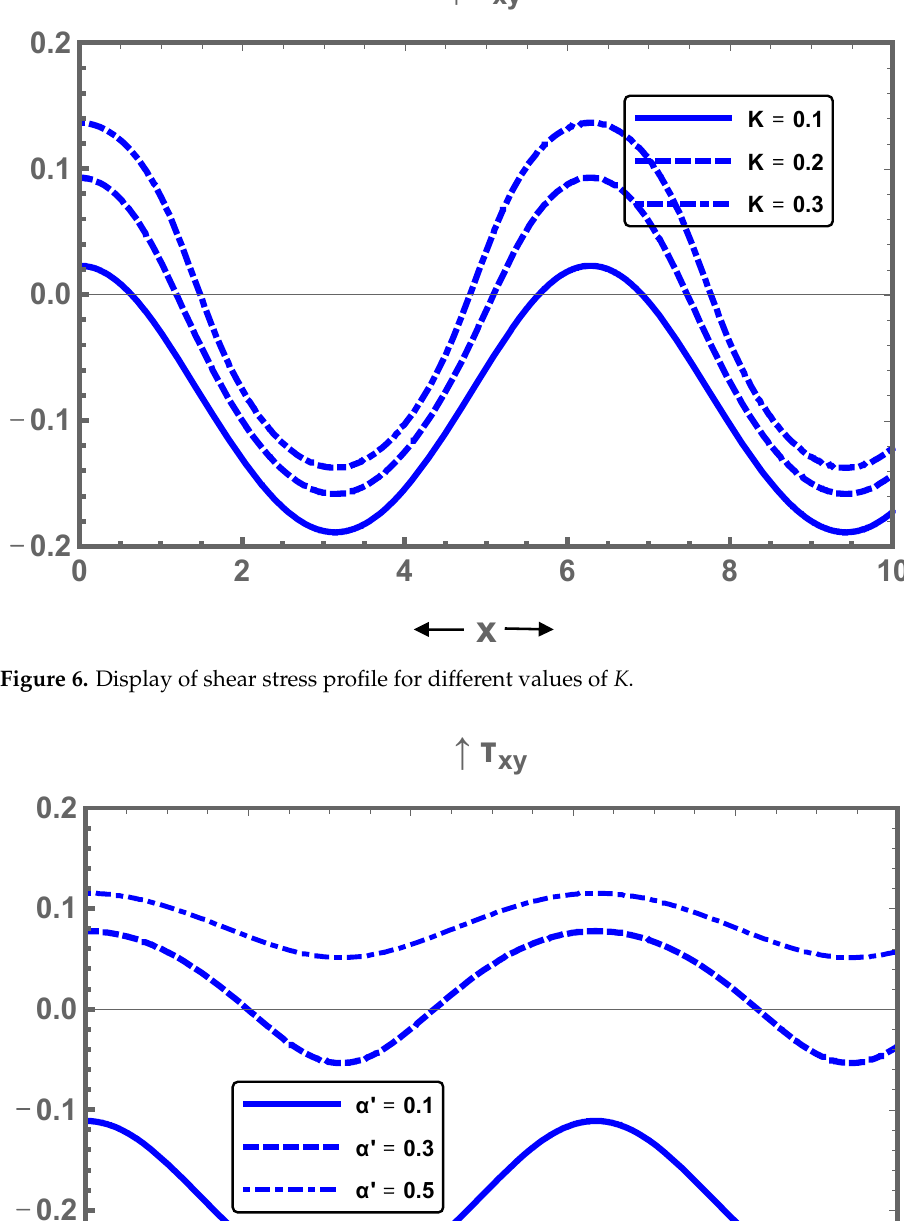
Figure 7. Display of shear stress profile for different values of 𝛼 (cid:4593) .